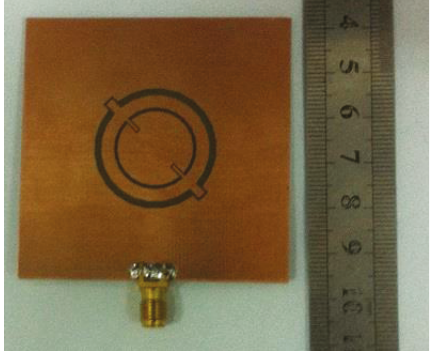
Figure 8: Photograph of the fabricated dual-band CP antenna.